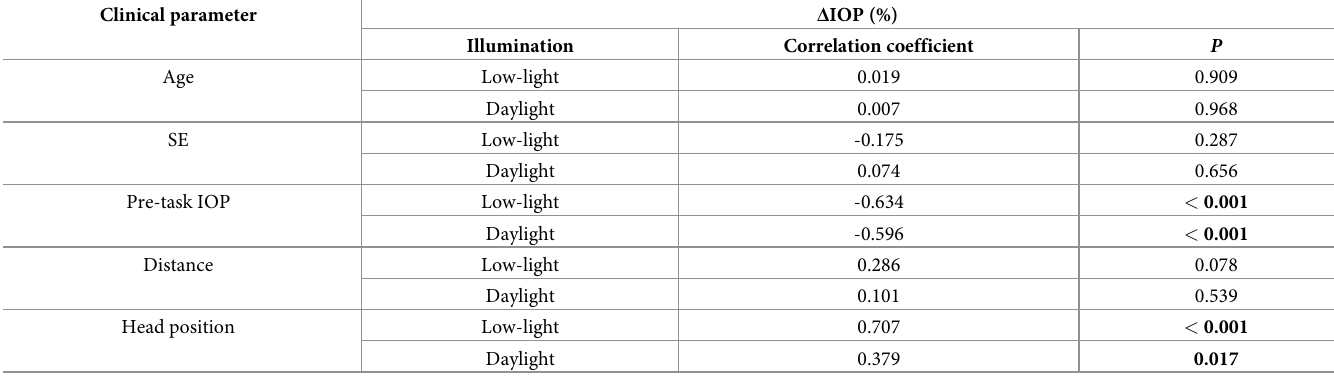
Table 3. Pearson correlation analysis between clinical parameters and intraocular pressure changes during smartphone task. Clinical parameter